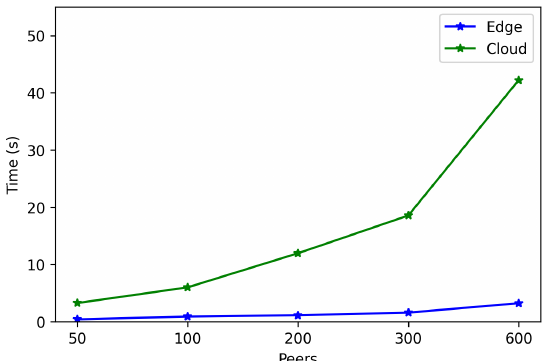
Figure 13. Mean total time when running the bootstrap node in the